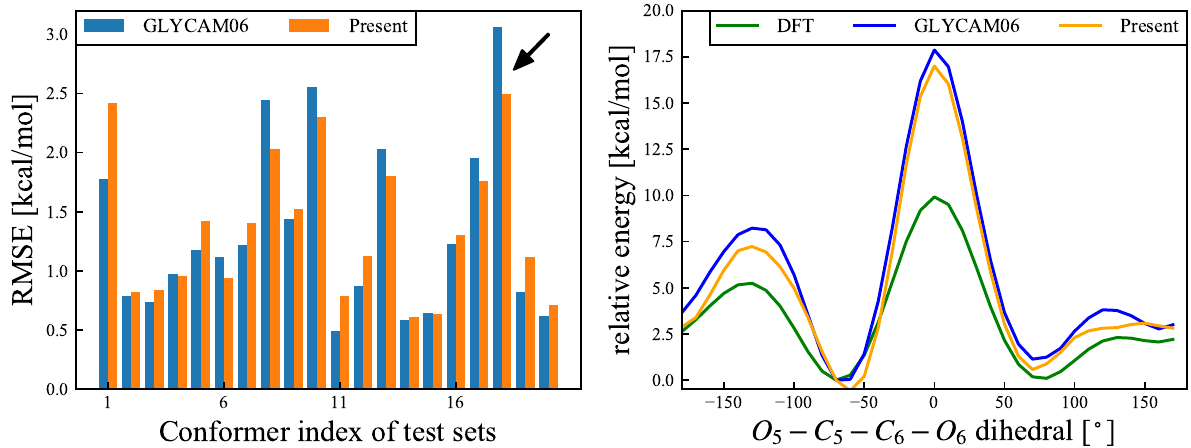
Figure 6. ( Left ): RMSEs (Equation (17)) for C 5 – C 6 rotational deformation modes for each of the 20 structures. Blue and orange bars refer to the results calculated using the GLYCAM06 force field and the force field proposed herin, respectively. The black arrow refers to the structure with the most improved RMSE, and the energy change of this structure is shown in the right panel. The average RMSE values for the 20 structures were 1.327 kcal/mol for the GLYCAM06 force field and 1.351 kcal/mol for the our proposed force field. ( Right ): Relative energy ( E s − E ref ) changes for the structure with the most improved RMSE as an example. The abscissa represents the O 5 – C 5 – C 6 – O 6 dihedral angle, and the ordinate represents the relative energy for the DFT and MM calculations, for the two different force fields. The reference structure was the most stable structure for the DFT calculations. The green, blue, and orange curves represent the relative energy changes for the DFT calculations, the GLYCAM06 force field, and our proposed force field,